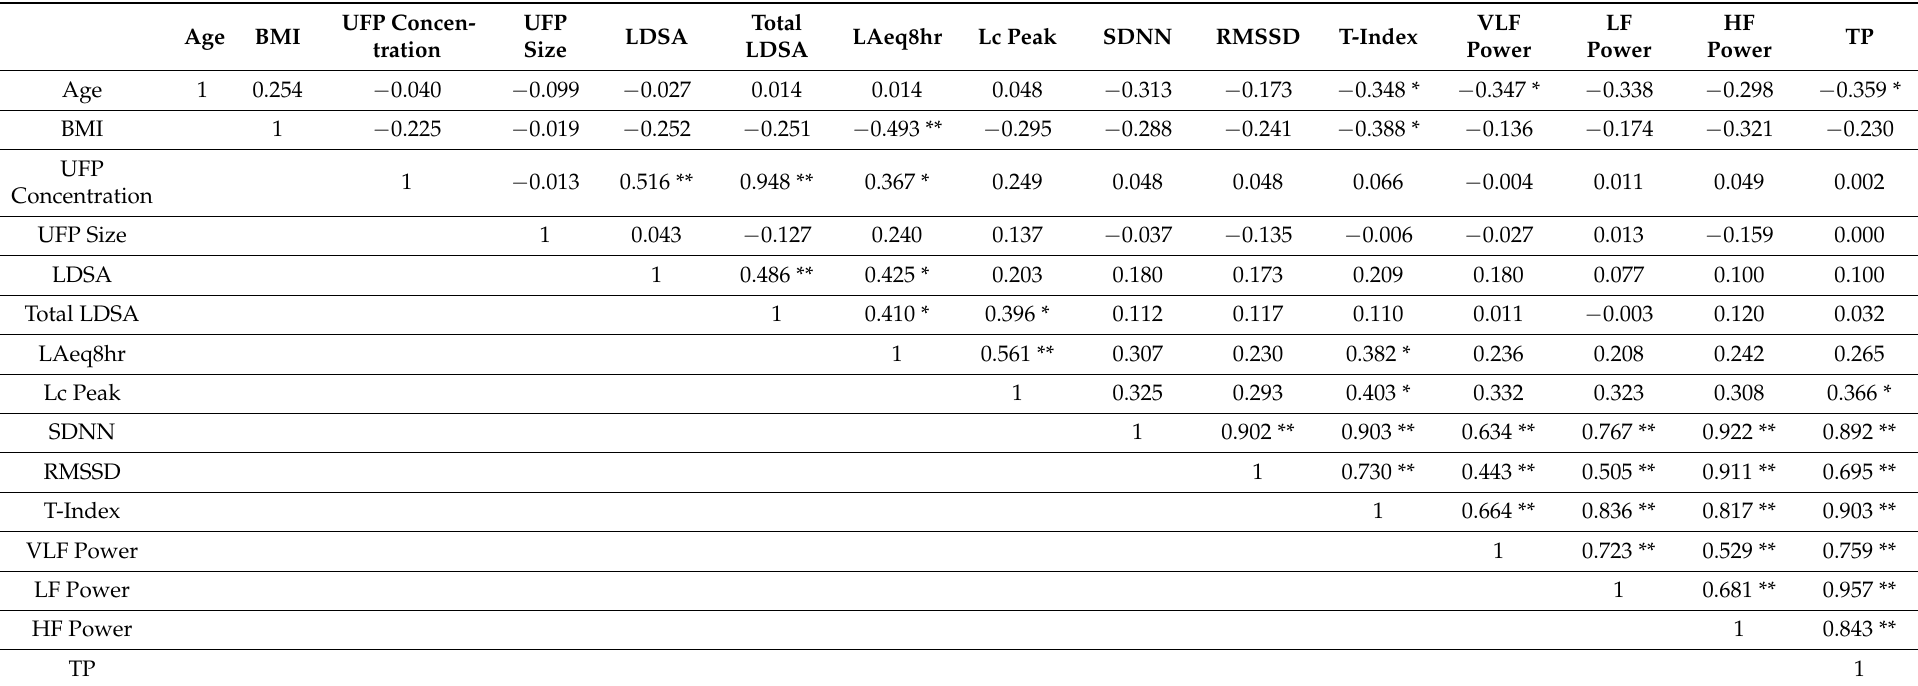
Table 3. Correlation matrix between parameters of exposure to UFP and noise, HRV parameters, and individual